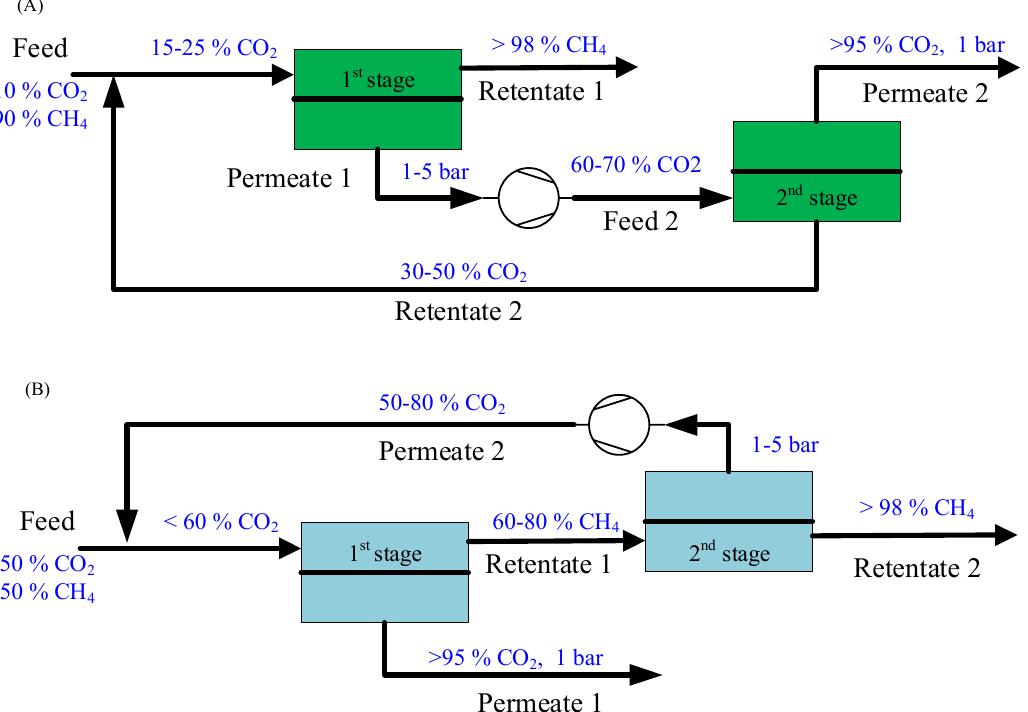
Figure 1. Membrane processes for natural gas (NG) sweetening, ( A ) 10% CO 2 feed; ( B ) 50% CO 2 feed.